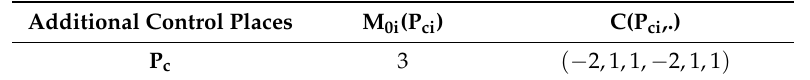
Table 4. PN controllers of Example